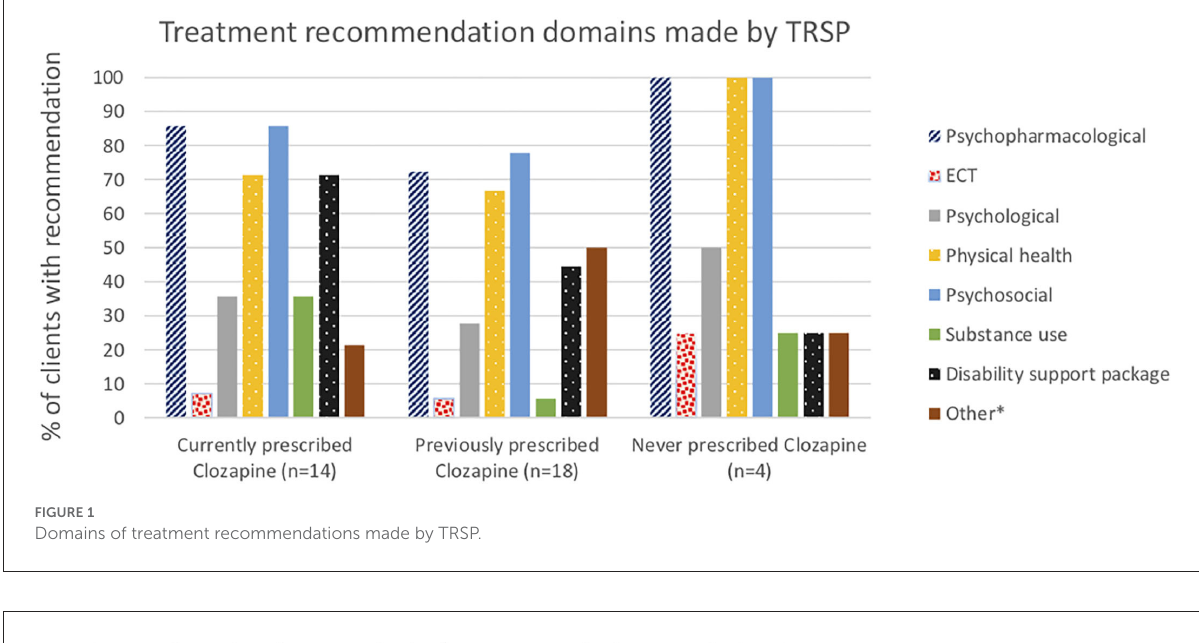
FIGURE1 Domains of treatment recommendations made by TRSP.